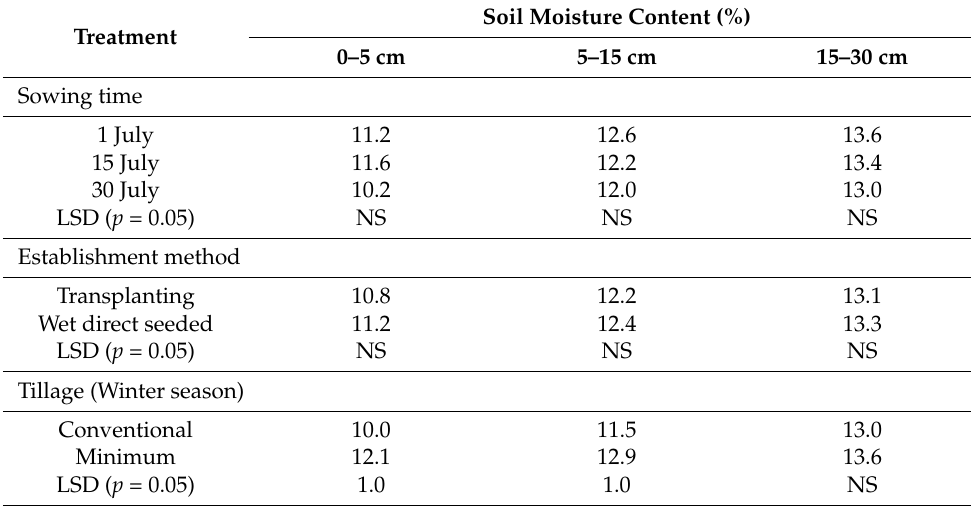
Table 10. Soil moisture content (%) at 0–15 cm depth of soil at 5 days after sowing of maize during the 5-year